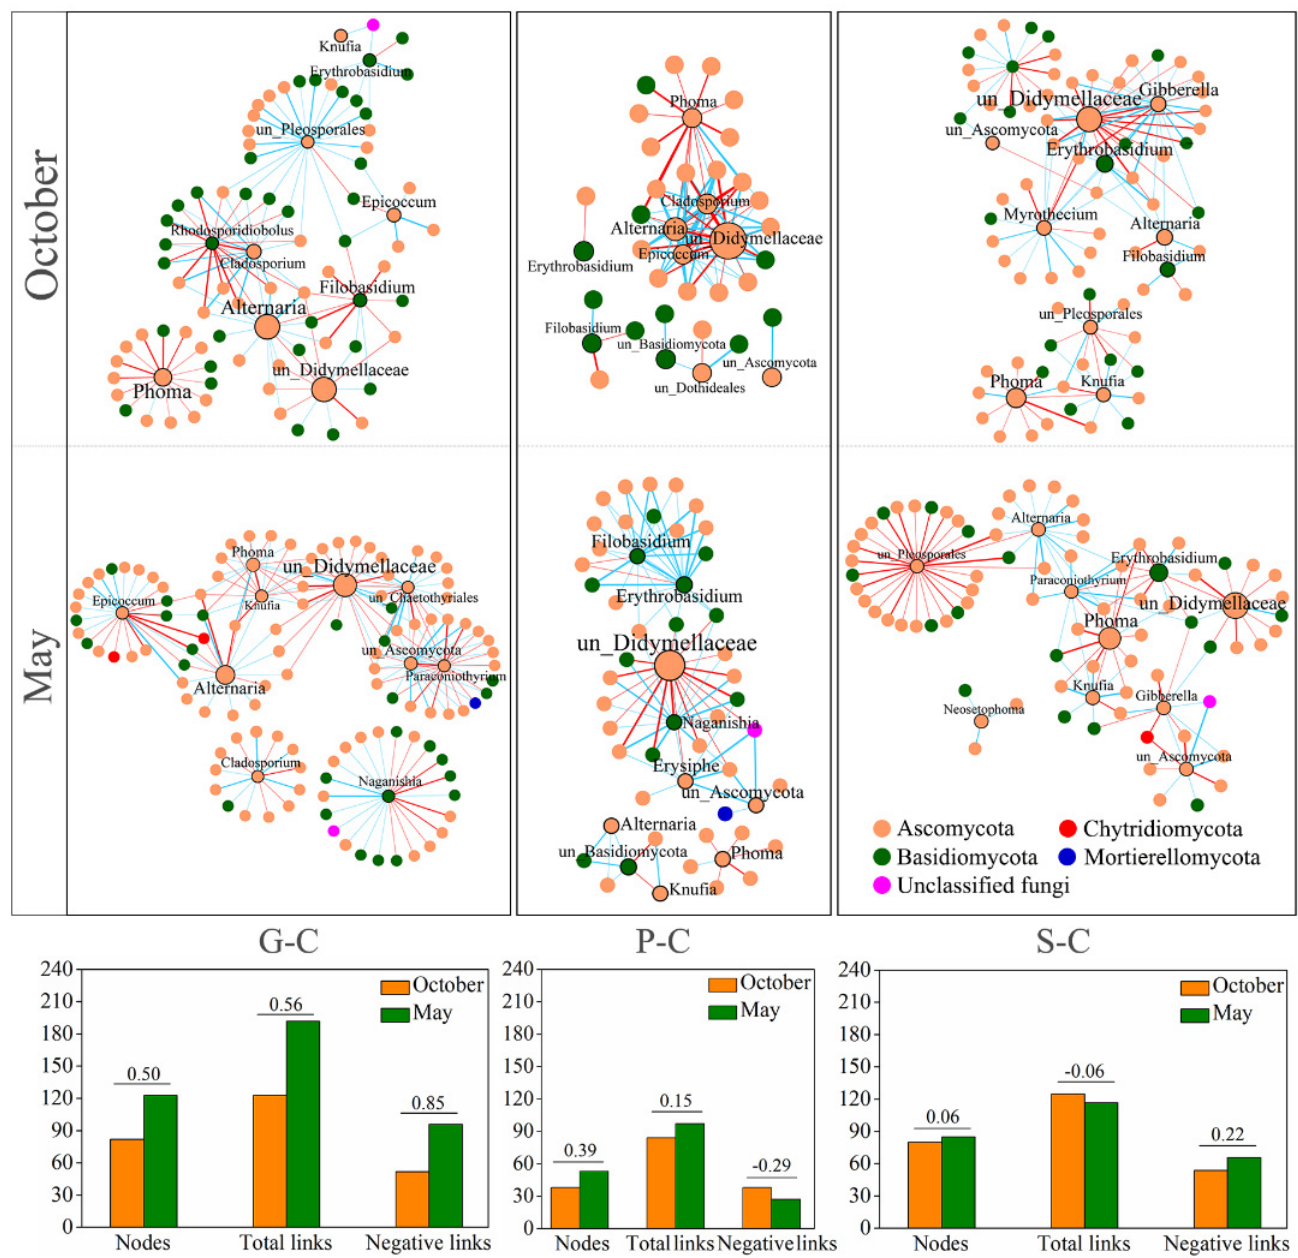
Figure 5. Fungal ITS region genera-based correlation network for G. biloba , P. bungeana and S. chinensis on campus in October and May. A node represents a genus. A connection stands for a strong (Spearman’s q > 0.75 or q < − 0.75) and significant ( p < 0.01) correlation. Edge widths are scaled according to their weights and edge colors indicate a positive (blue) or negative (red) correlation for the nodes they connect. The numbers on columns indicate the ratio of increase in May compared to October. G-C, G. biloba from campus; P-C, P. bungeana from campus; S-C, S. chinensis from campus.